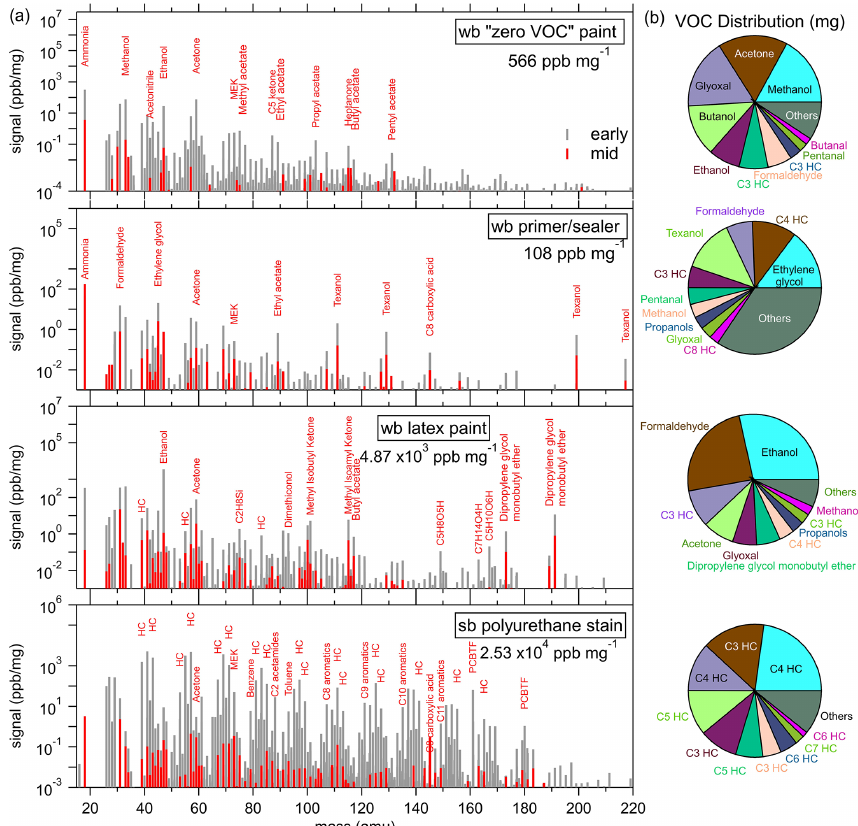
Figure 5. (a) PTR-ToF-MS mass spectra of a water-borne (wb) low VOC paint, a wb primer and/or sealer paint, a wb latex paint, and a solvent-borne (sb) polyurethane stain, where the major peaks are labeled by their most likely identification. The values (in ppbv) are normalized to the weight loss of the product on the scale during the evaporation experiment. In each panel, a mass spectra in the early part (gray) of the experiment and one in the middle part (red) is shown. The total VOC signal taken from the early mass scan per milligram of product is indicated in the legend. (b) Pie charts of the total mass emitted by individual VOCs during evaporation experiments. Several small hydrocarbon masses could not be explicitly identified due to the fragmentation of larger masses and are instead labeled by their carbon